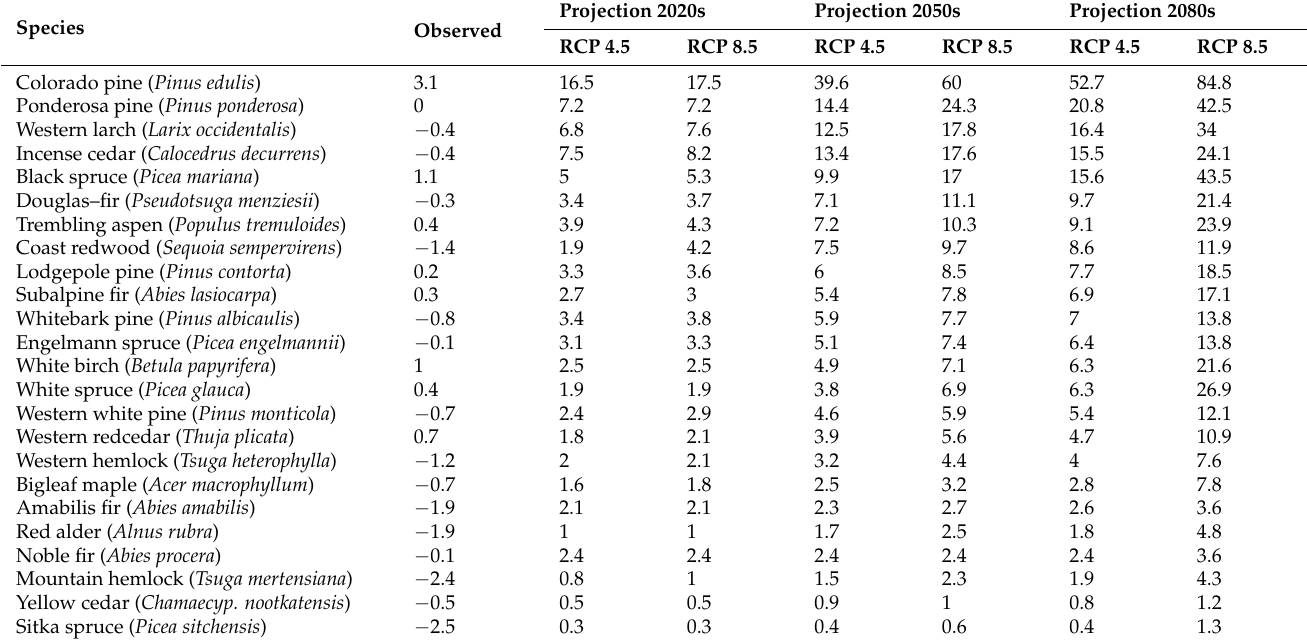
Table 2. Percentage of plot locations that additionally fall below the 2.5th percentile threshold shown in Table 1 under observed and projected climate